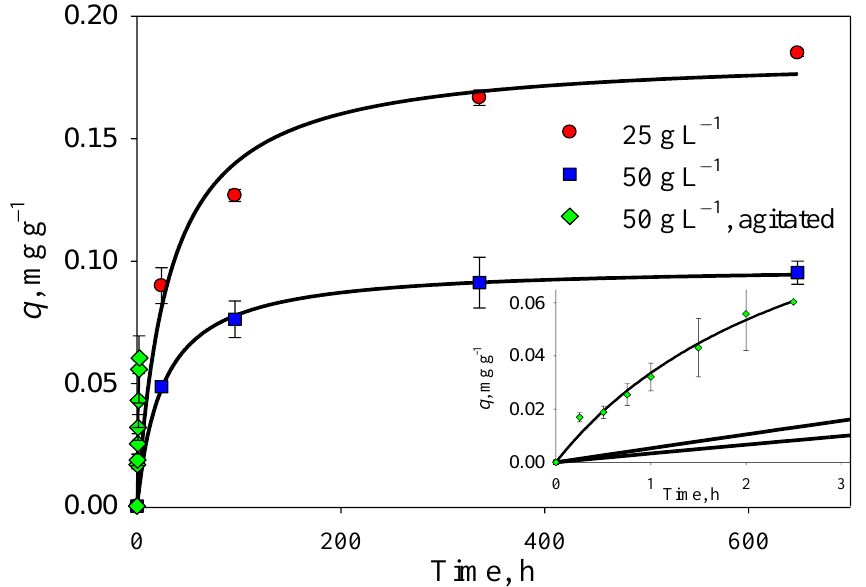
Figure 7. Kinetics of adsorption of As(III) on the clay, with and without orbital agitation. Conditions: [As(III)] = 5 mg L − 1 , pH 7, [clay] = 25 g L − 1 or 50 g L − 1 , RT, EC = 0.03 mS cm − 1 , agitation 0 rpm or 100 rpm. Full lines: adjustment to Equation (6). Inset: zoom-in to the first 3 h of reaction.